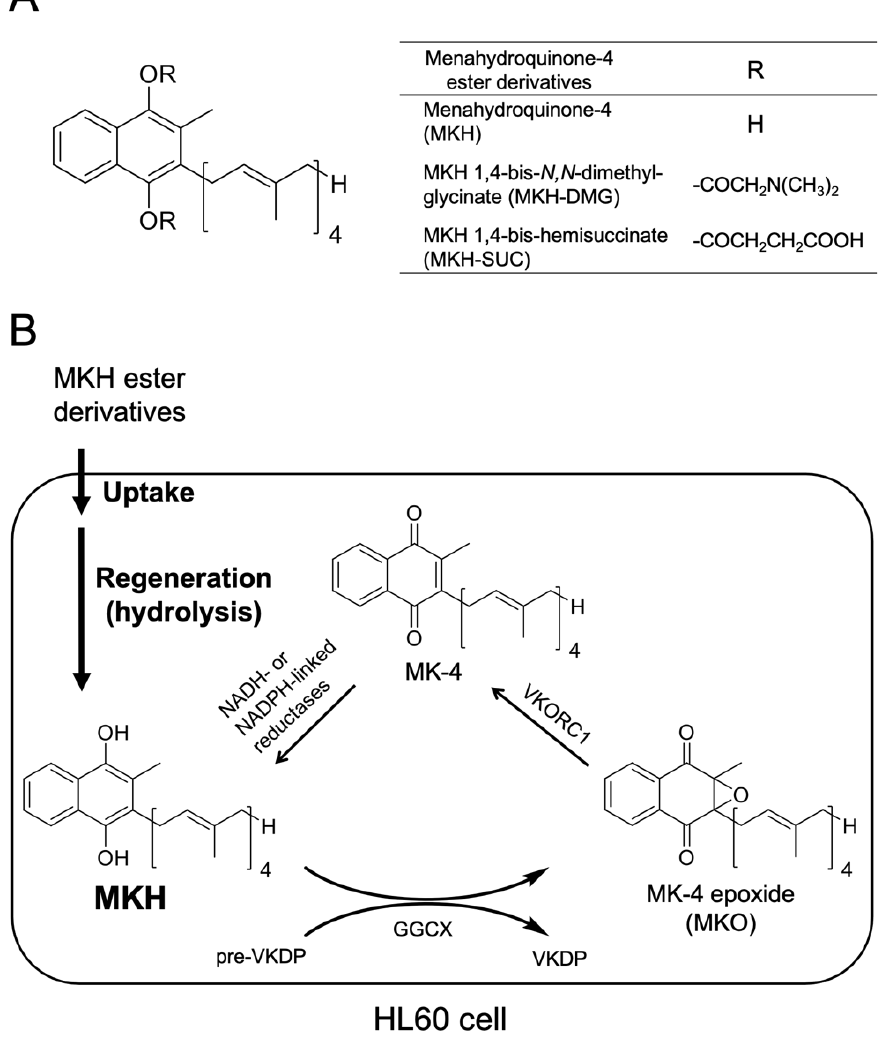
Figure 1. Chemical structure of MKH derivatives ( A ). The activation step for MKH derivatives, and the vitamin K cycle in HL60 cells ( B ). MKH, menahydroquinone-4; MK-4, menaquinone-4; MKO, menaquinone-4 epoxide; VKR, vitamin K reductase; VKOR, vitamin K epoxide reductase; VKDP, vitamin K-dependent proteins; GGCX, γ-glutamyl carboxylase.